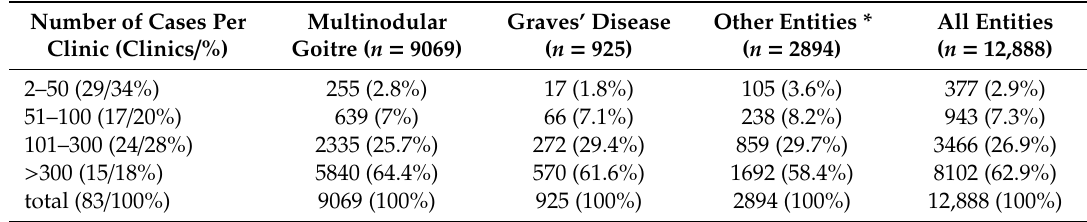
Table 1. Number of thyroid procedures and operated entities of participating